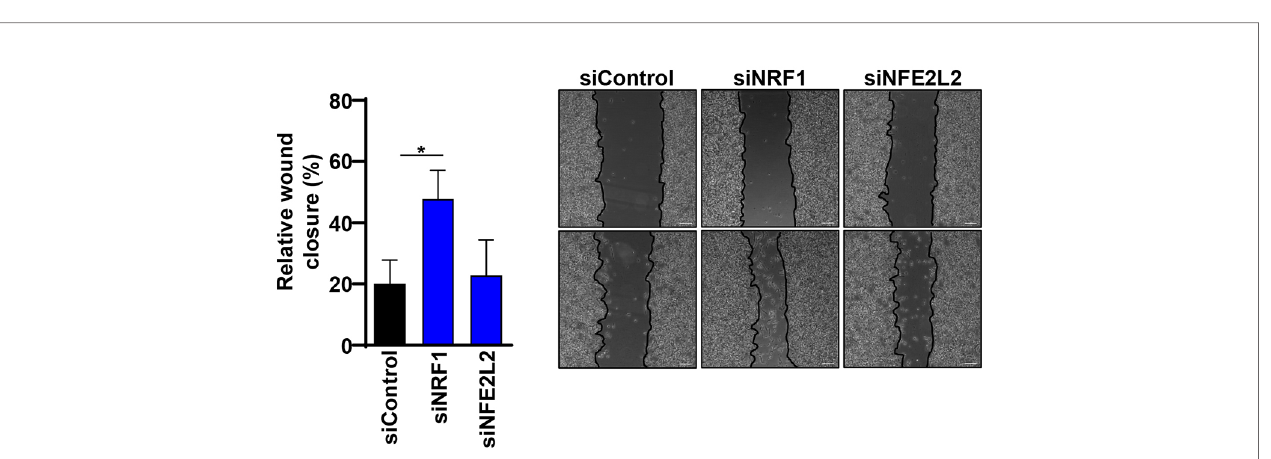
FIGURE 7 | Knockdown of NRF1 increased the migration potential of melanoma cells. The wound-healing assay was made on overnight serum-starved, con fl uent melanoma cells by drawing a line across the bottom of the dish. The scratch was performed on cells that were previously treated with 50 nM siRNAs (Dharmacon) against NRF1 and NFE2L2 or Non-Targeting siRNA (siControl) for 48 h. Phase-contrast microscopy pictures were taken of the wounded area. Cell migration quanti fi cation of pictures is represented as the empty area from t=0 h normalized to empty area from t=24 h. Statistical analysis was performed by comparing all groups to the untreated control group using a one-way ANOVA, with Dunnett ’ s correction for multiple comparisons (n=3). p ≤ 0.05*. Scale 100 m m.